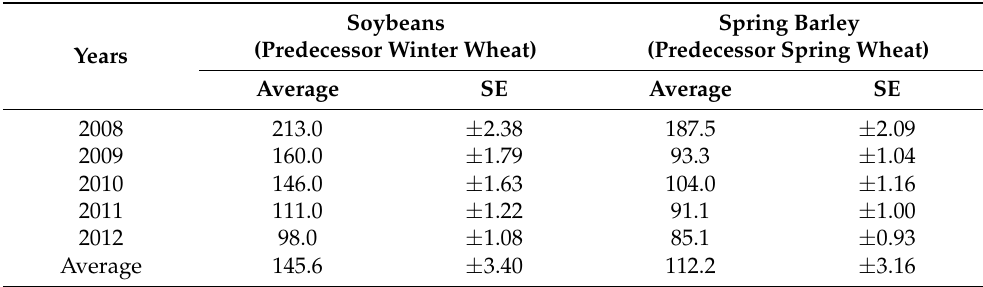
larvae and 37.8 ind./m 2 (SE = ± 0.5)—pronymphs (Table 2). Table 2. Average number of larvae of wheat thrips of the second stage/pronymphs in stubble remains, ind./m 2 . Soybeans Spring Barley (Predecessor Winter Wheat) (Predecessor Spring Wheat) Years Average SE Average SE 2008 73.0/45.0 ± 0.81/ ± 0.50 41.0/19.0 ± 0.46/ ± 0.21 58.3/39.6